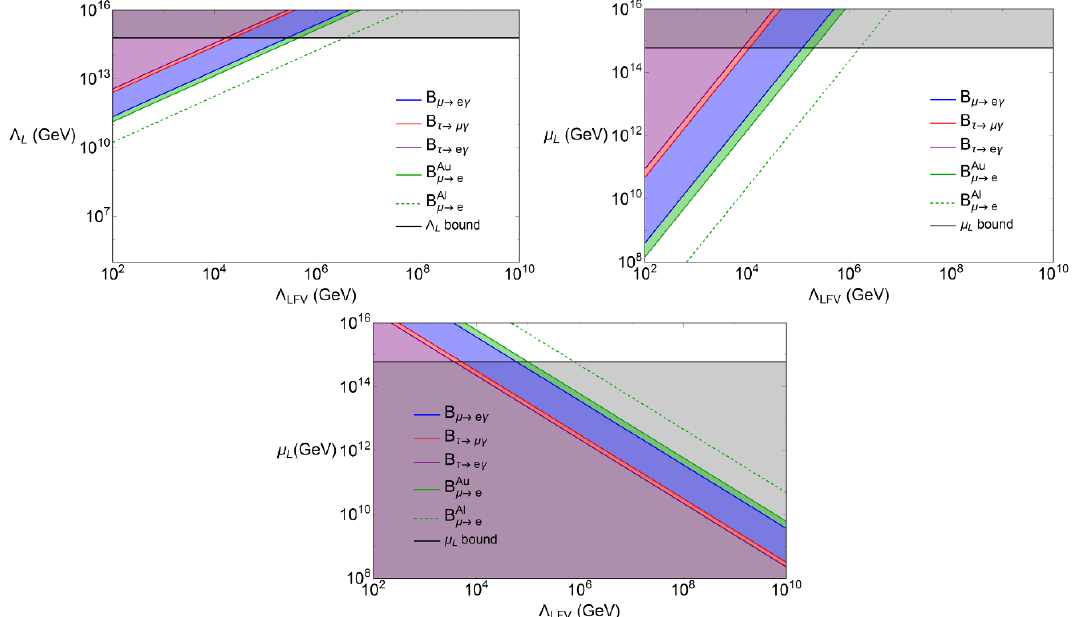
JHEP07(2017)089 Figure 1. Parameter space for the LFV and LNV scales constrained by requiring perturbativity of the spurion backgrounds and by the present experimental bounds on (cid:22) ! e conversion in gold (in green), BR ( (cid:22) ! e(cid:13) ) (in blue), BR ( (cid:28) ! (cid:22)(cid:13) ) (in red), and BR ( (cid:28) ! e(cid:13) ) (in purple). Taking into account the expected future sensitivity on BR ( (cid:22) ! e(cid:13) ) would not restrict further the parameter space in the case of a negative result: the prospective bound would almost coincide with the bound from the negative search for (cid:22) ! e conversion in gold, BR ( (cid:22) ! e ). However, with the planned signi(cid:12)cant increase (by more than 4 orders of magnitude) of the sensitivity to the relative rate of (cid:22) ! e conversion in aluminium it would be possible to probe considerably larger fraction of the parameter space of interest: the corresponding bound is drown as the green dashed line. The grey region are excluded areas from the constraints on the LNV scale, eqs. (2.15), (2.25), and (2.30). The left, middle and right panels correspond to the MFC, EFCI and EFCII cases, respectively. The border lines are obtained taking as input data the best (cid:12)t values for the oscillation parameters listed in table 1 and the nuclear quantities in table 2. The Dirac CP phase for the EFCI plot is set equal to (cid:25) , while the Majorana are set to 0, in order to minimise the excluded region of the parameter space. For the EFCI and EFCII cases, a quasi-degenerate neutrino mass spectrum with m lightest = 0 : 1 eV has been assumed, which also minimised the excluded areas. In all the cases, (cid:23) the Lagrangian coe(cid:14)cients have been (cid:12)xed in a democratic way not to favour any speci(cid:12)c operator as well, as no di(cid:11)erence is appreciable. On the other hand, a dependence on the strength of the splitting between neutrino masses can be found for the EFC scenarios: the plots reported here illustrate the almost degenerate case, where the lightest neutrino mass is taken to be O (0 : 1 eV); stronger hierarchies result in a more constrained parameter space. Finally, the plot for EFCI refers to (cid:14) ‘ = (cid:25) , but the other case with (cid:14) ‘ = 0 is almost CP CP